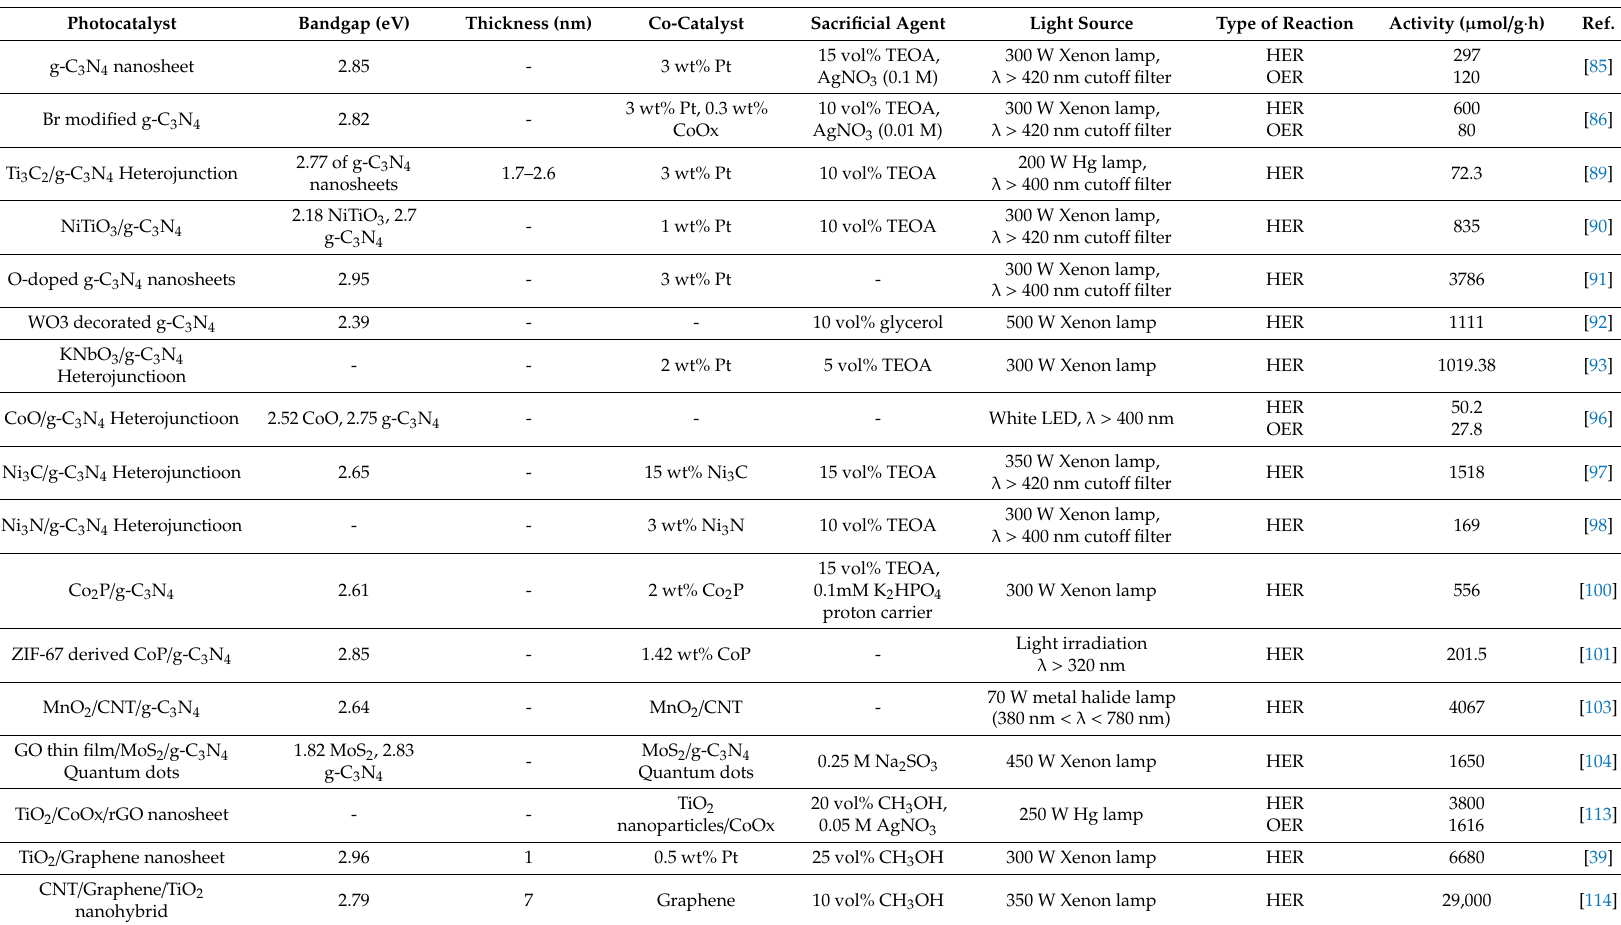
Table 2. Summary of photocatalytic water splitting systems discussed in this article involving g-C 3 N 4 , graphene, phosphine, metal phosphides and metal organic frameworks